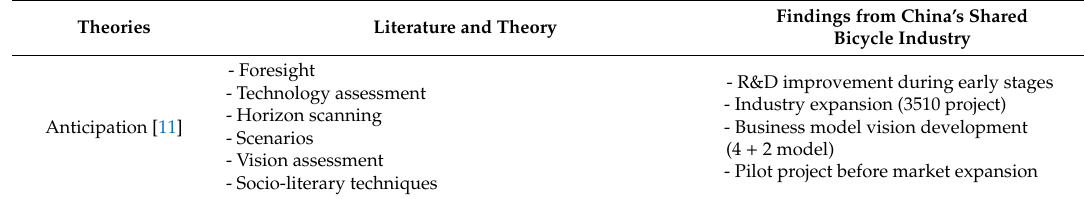
Table 2. Dimensions of responsible